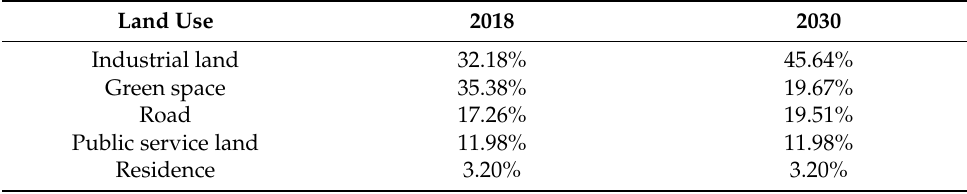
Figure 1. Information regarding the study area: ( a ) Location and scale of the study area; ( b ) Land use types currently (2018) and in the future (2030). Table 1. Land use information in